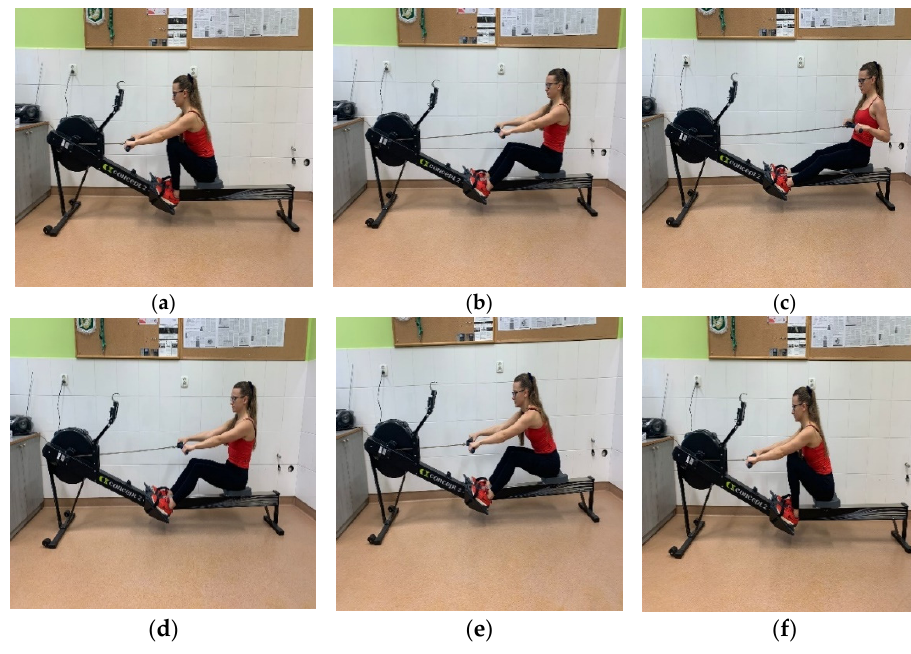
Figure 1. Rowing phases ( a – f ) on the Concept 2 PM5 indoor rowing ergometer .